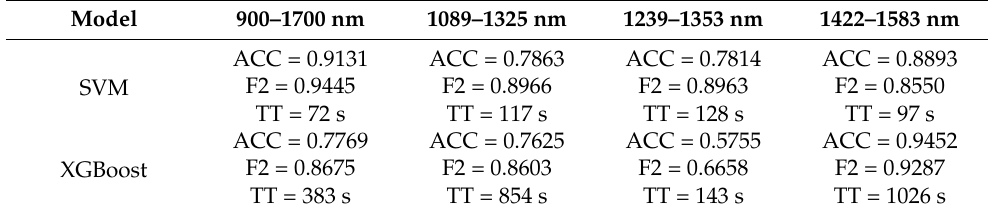
Table 7. Classification results of the ML models.